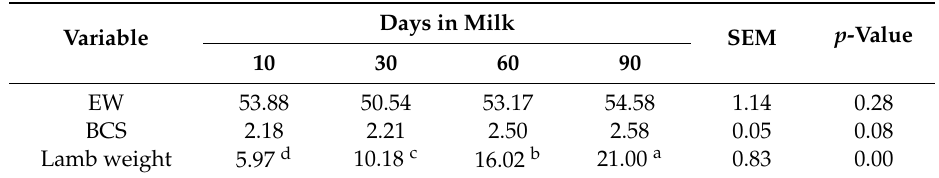
Table 2. Ewe weight (EW) and body condition score (BCS) of Araucana creole ewes ( n = 20) during lactation and liveweight of Araucana creole lambs ( n = 20). SEM: standard error of the mean; a,b,c,d means with different superscript are significantly different ( p < 0.05).